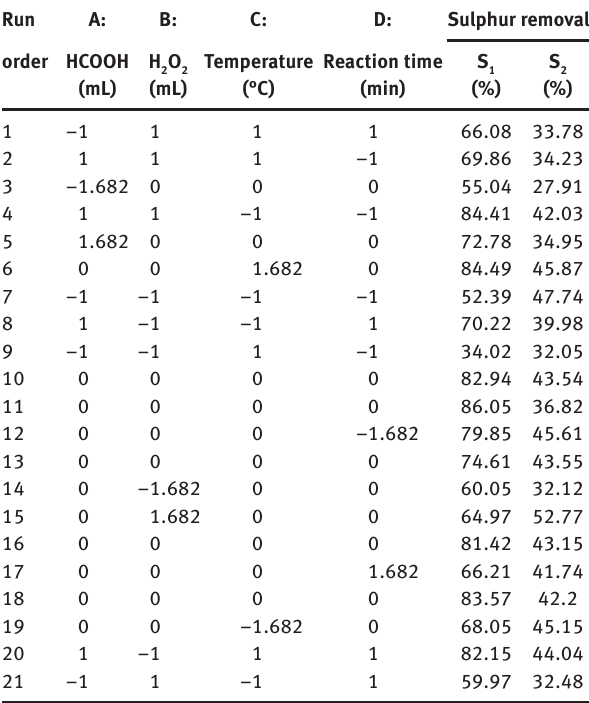
Table 2: CCD of sulphur removal for various parametric interactions.